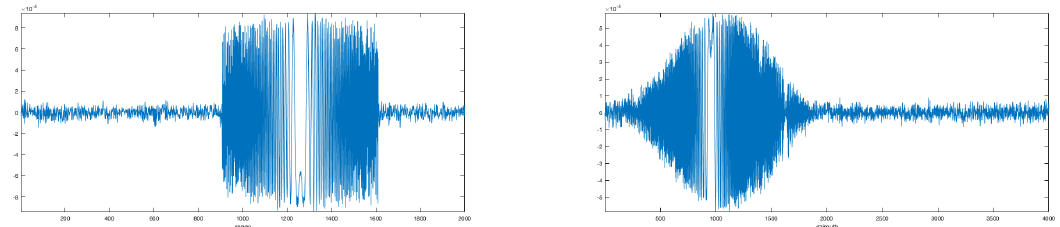
Figure 3. Real parts of first right and first left singular vectors for the SAR raw data matrix decomposition. The range amplitude results almost constant, as the transmitted chirp is assumed to be. The azimuth singular vector is shaped by the azimuth antenna beam